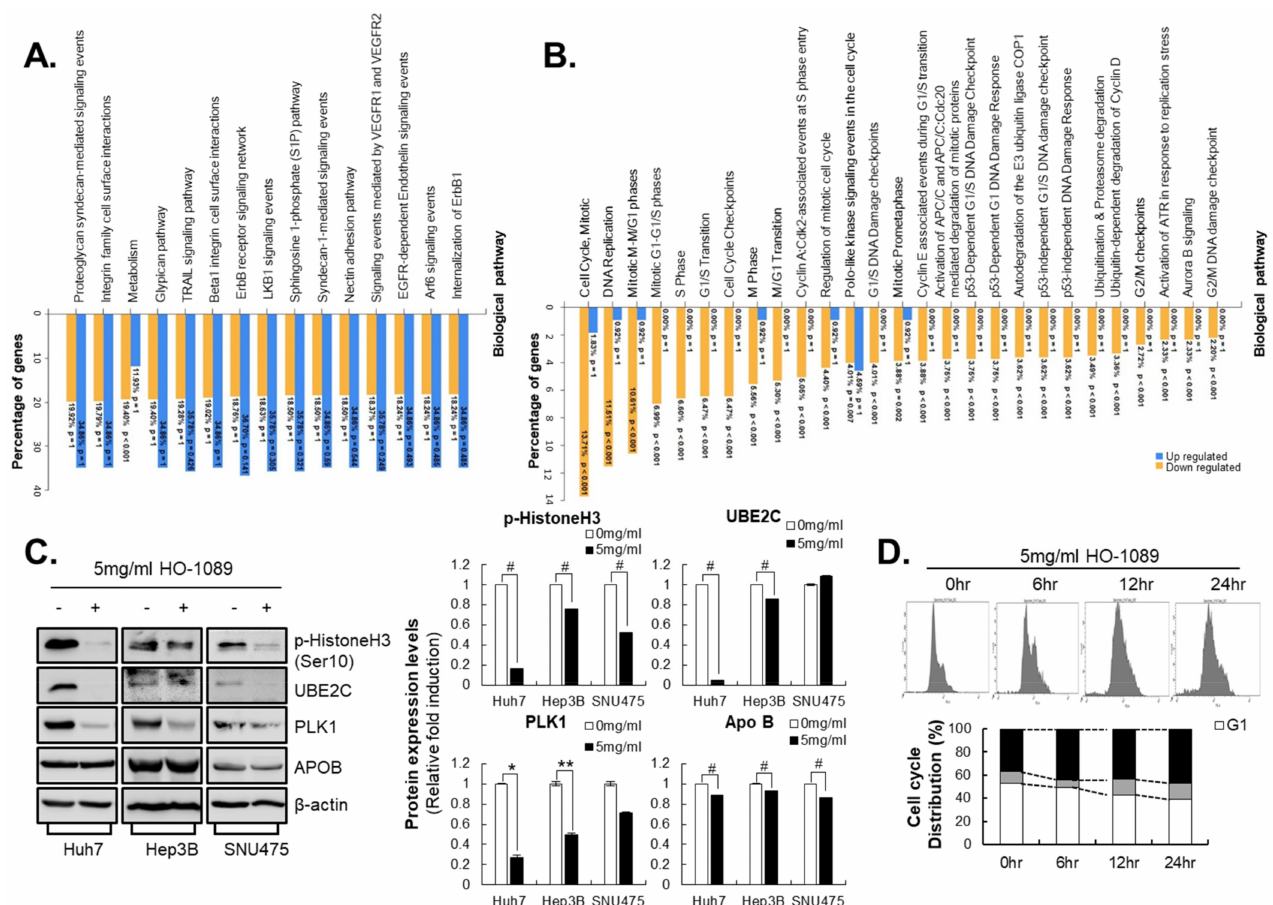
Figure 4. Suppression of mitosis-related protein induced by HO-1089 treatment: ( A , B ) The biological pathway of HO-1089 was analyzed using microarray analysis. Huh7 cells were treated with 5 mg/mL HO-1089 for 48 h. Cell cycle and mitosis-related gene expression were calculated and compared. The graphs show the percentages of genes that are not significantly changed ( A ), or significantly hanged ( B ), as well as their expression levels. ( C ) The genes from microarray analysis for which HO-1089 exposure changed the expression levels were examined in Huh7, Hep3B, and SNU475 cells (left panel). The Western blot images were quantitatively analyzed (right panel). ( D ) Cell cycle distributions induced by HO-1089 treatment in Huh7 cells were calculated at 0, 6, 12, and 24 h after treatment. Data are expressed as means ± SD ( n = 3). * p < 0.05, ** p < 0.005, # p < 0.0005 compared